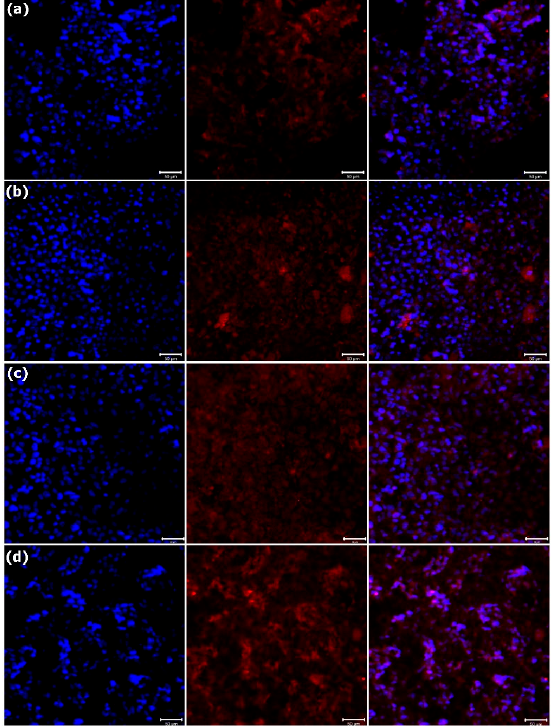
Figure 9. Immunofluorescence analysis of OCN on ( a ) PCL, ( b ) PCL–SrHANF (65), ( c ) PCL–SrHANF (130), and ( d ) PCL–SrHANF (195) after 14 days of culture. The MG63 osteoblast-like cells were stained with OCN ( red ), and the cell nuclei were stained with DAPI ( blue ). Scale bar = 50 µm.